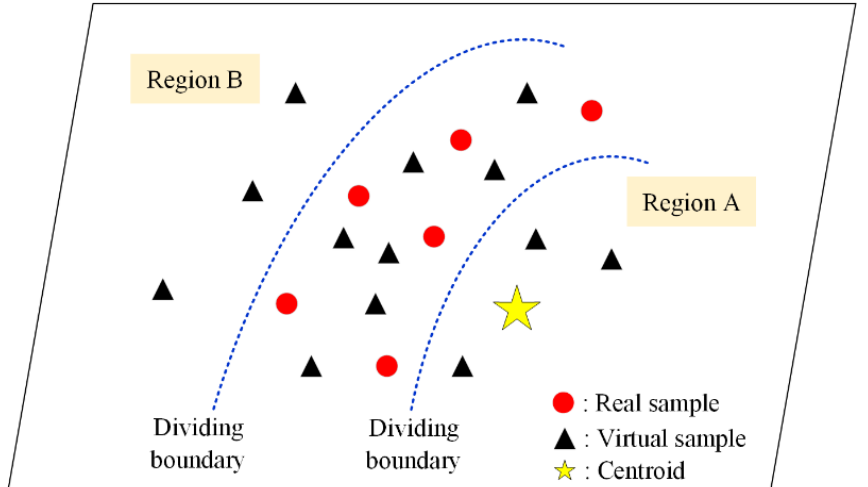
Figure 2. The distribution of most virtual samples conforms to the real data distribution. However, the WGAN-GP also generates samples that are located in regions A and B, which are far from the distribution of the original data. If the generated samples in regions A and B, which are regarded as unqualified, are added to the original set, the prediction performance of the model may deteriorate. A detailed description of the proposed selection strategy is provided below.